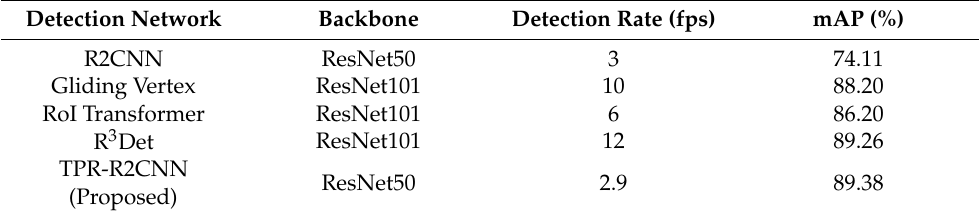
Table 6. Comparisons with the state-of-the-art methods on